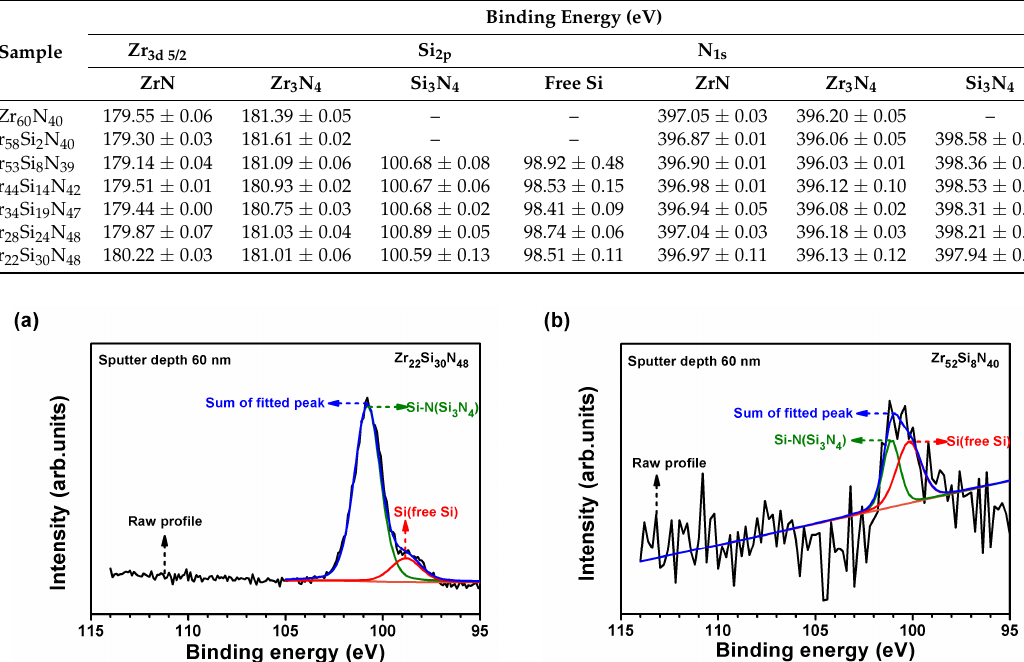
Figure 8. XPS profiles of N 1s core levels of Zr 22 Si 30 N 48 (0.4,R5) coatings at a depth of 60 nm.